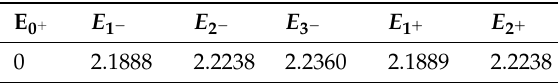
Table 1. Energy levels of the model atom.